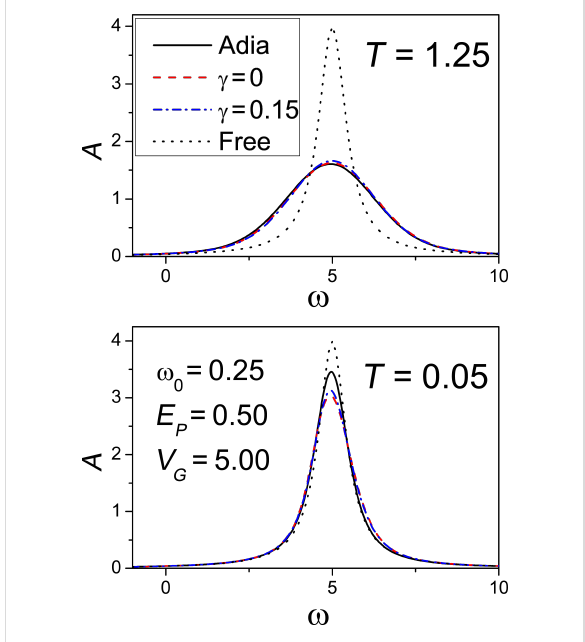
Figure 2: Analysis of the validity of the adiabatic approximation. Elec- tronic spectral function as a function of the frequency (in units of Γ ) for adiabatic approach (solid line), fully quantum low-density approach (dashed line for γ = 0, dash-dotted line for γ = 0.15), and free case (dotted line) at temperature T = 1.25 / k B (upper panel) and tempera- ture T = 0.05 / k B (lower panel). In all the plots, E P = 0.5 , V G = 5 , and ω 0 = 0.25 Γ .